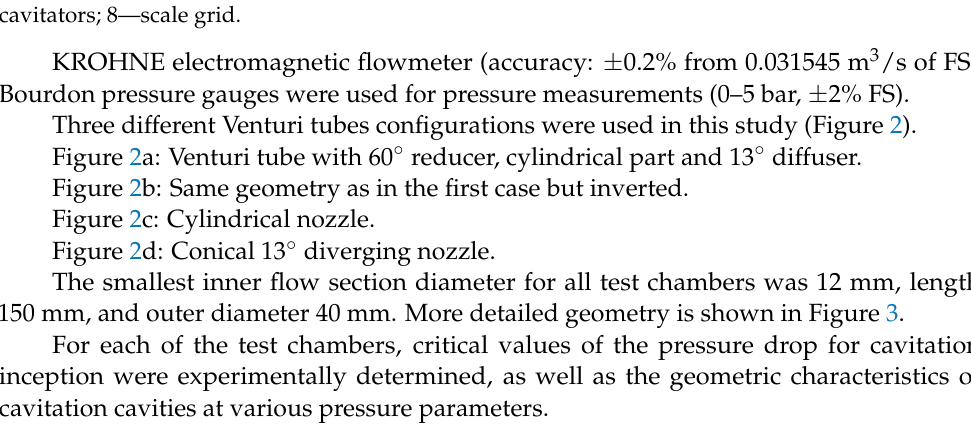
Figure 2a: Venturi tube with 60° reducer, cylindrical part and 13° diffuser. Figure 2b: Same geometry as in the first case but inverted. Figure 2c: Cylindrical nozzle. Figure 2d: Conical 13° diverging nozzle.